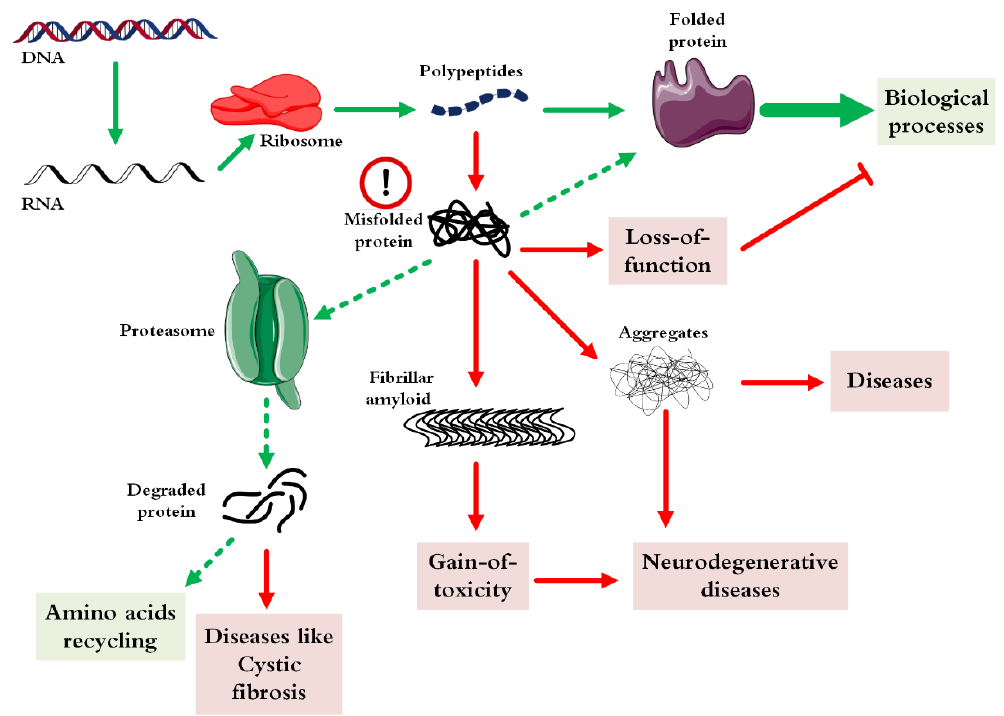
Figure 1. Possible intracellular pathways of correct and/or incorrect protein folding.